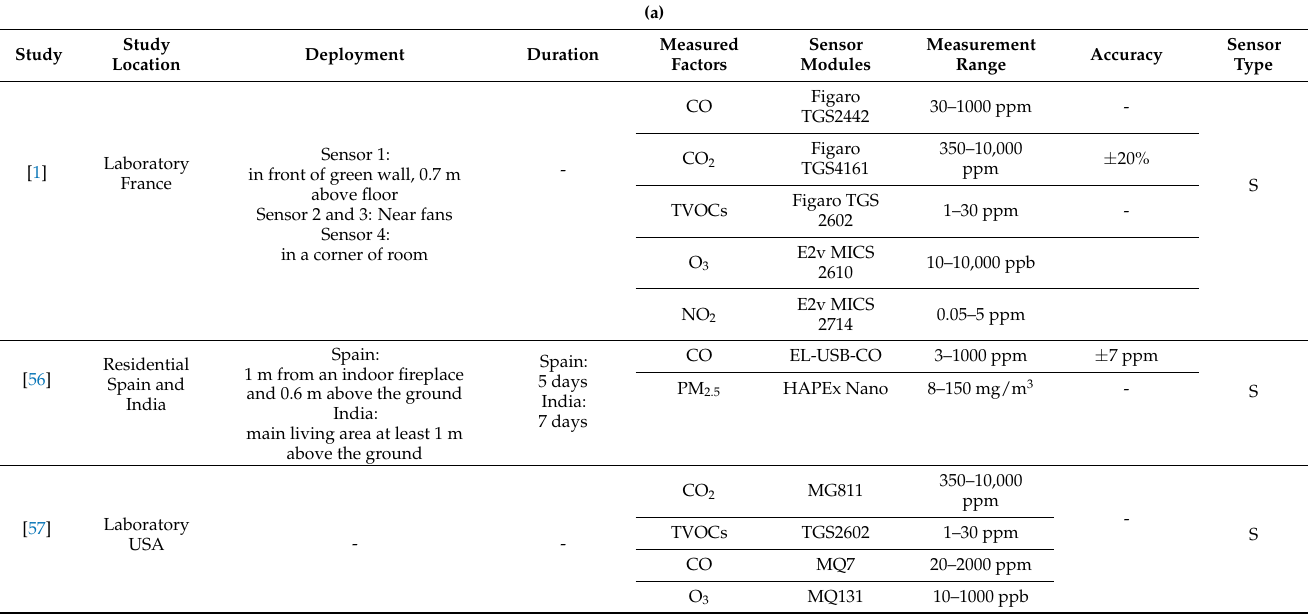
Table 3. (a). Air quality sensing systems characteristics, deployment, and study information. (b). Summary of occupant information and feedback collected in the